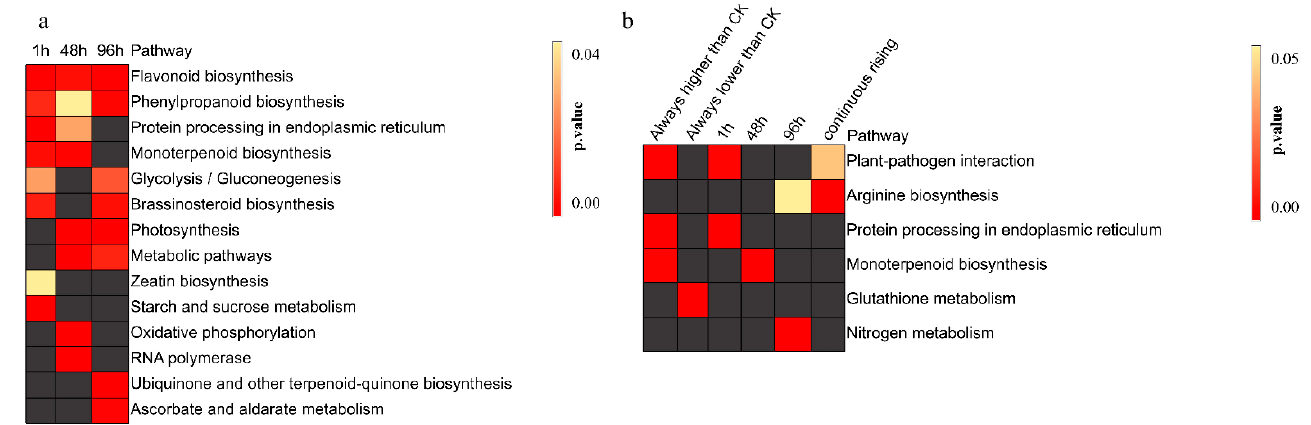
Figure 2. KEGG enrichment analysis of DEGs. ( a ) KEGG enrichment analysis of DEGs after 1 h, 48 h and 96 h heat stress. ( b ) KEGG enrichment analysis after K-means clustering. Gray represents not enriched.